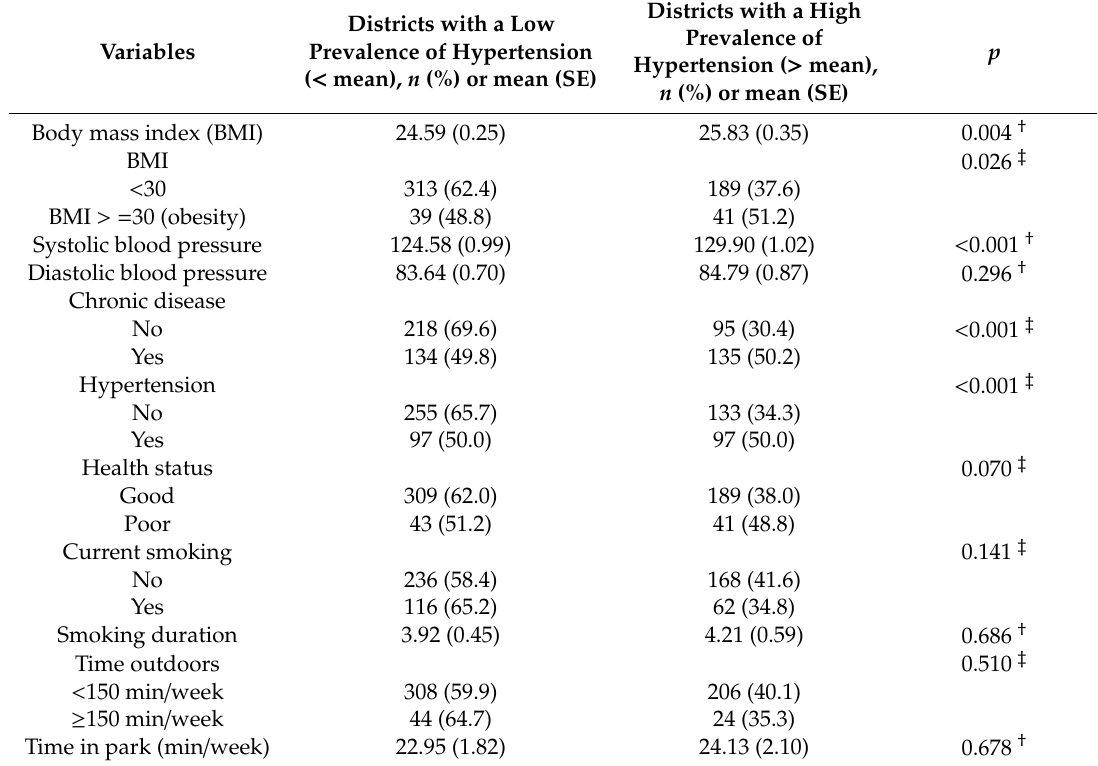
Table 2. Self-reported physical activity and health measures in district groups by the prevalence of